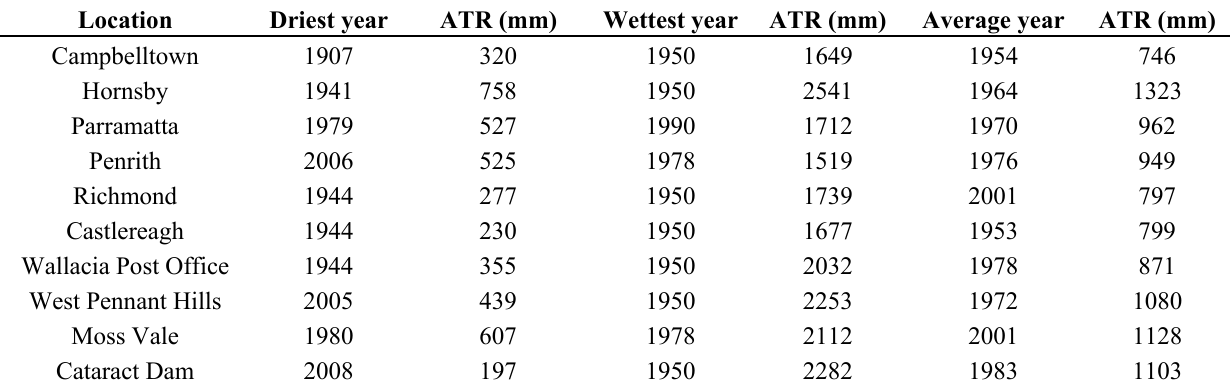
Table 4. Reliability and water savings at Campbelltown, Hornsby and Richmond for a 5 kL rainwater tank for toilet and laundry use for the driest, wettest and average years on record.